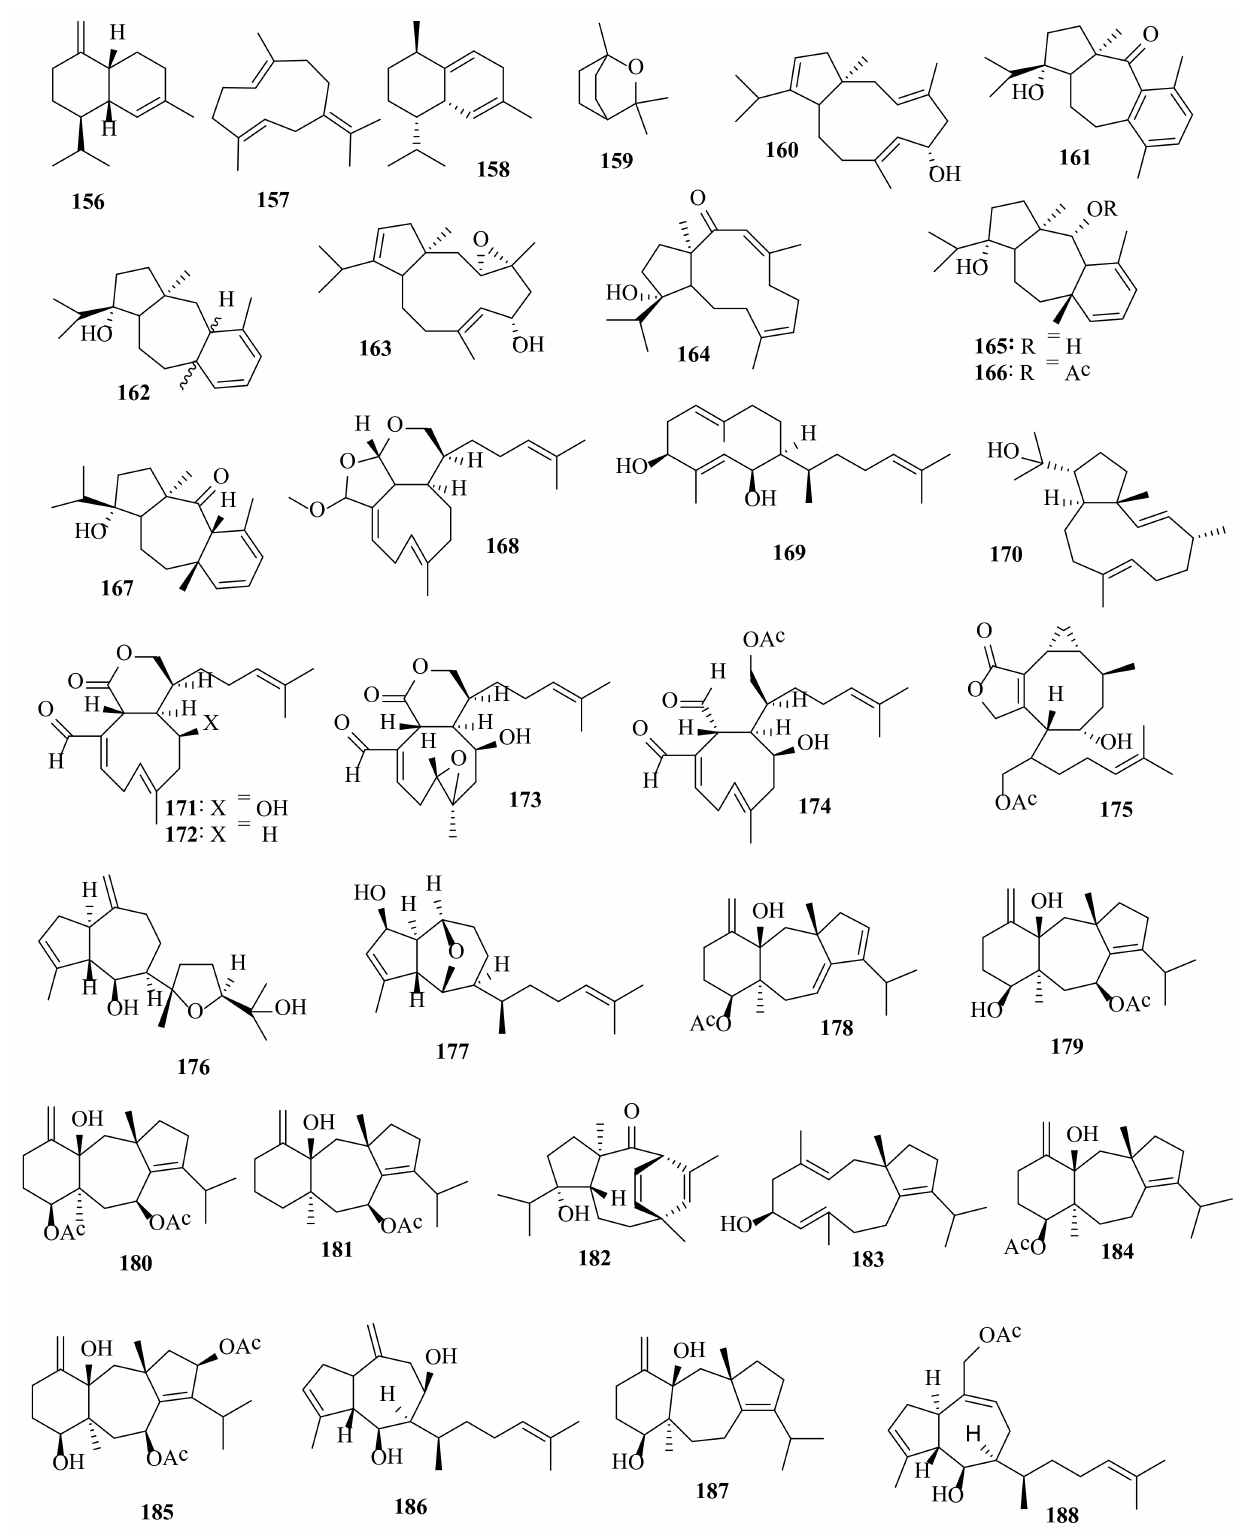
Figure 7. Chemical structures of compounds 156 – 188 . Sesquiterpenes 156 – 159 were isolated from D. dichotoma , diterpenes 160 – 182 were isolated from D. dichotoma var. divaricata , and diterpenes 183 – 188 were isolated from D. dichotoma var. implexa. The configuration of all stereocenters in each compound is shown as given in the